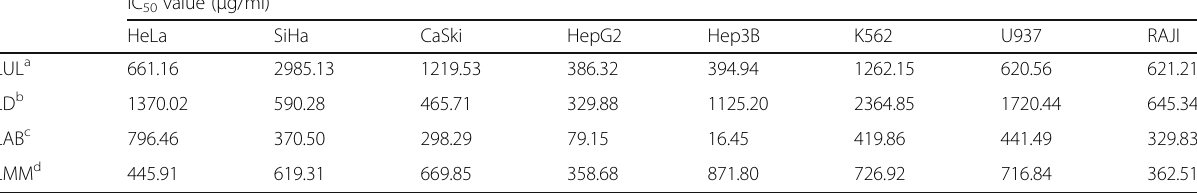
Table 2 IC 50 values of leaf crude extracts against cancer cell lines IC 50 value ( μ g/ml)